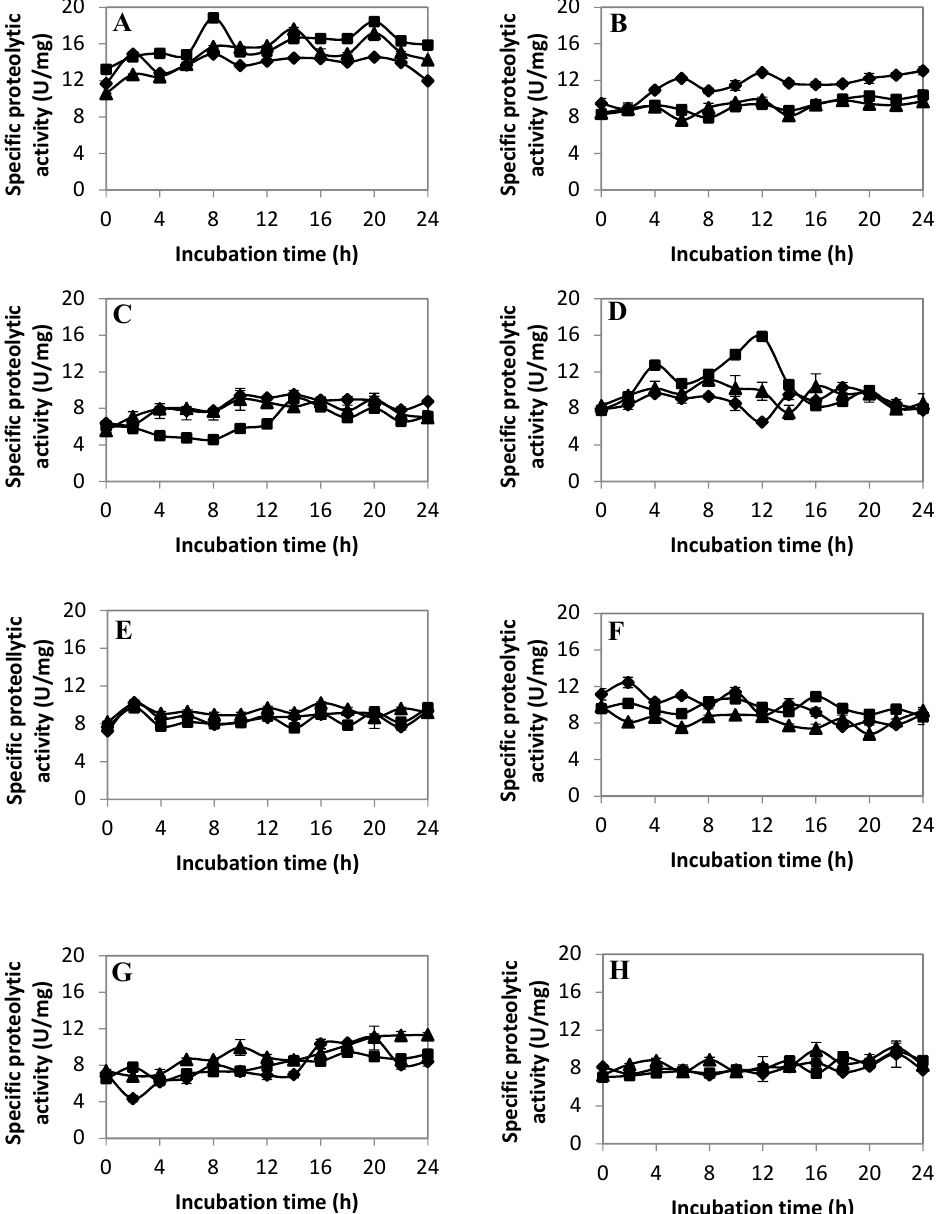
Figure 3. The specific extracellular proteolytic activities of different LAB isolates under pH5 ( (cid:7) ), pH 6.5 ( (cid:4) ) and pH 8 ( (cid:78) ) conditions: ( A ) P. acidilactici UP-1; ( B) P. pentosaceus UP-2; ( C) P. pentosaceus UB-6; ( D ) P. pentosaceus UB-8; ( E ) P. pentosaceus UL-2; ( F ) P. acidilactici UL-3; ( G) L. plantarum UL-4; and ( H ) P. pentosaceus UL-6.